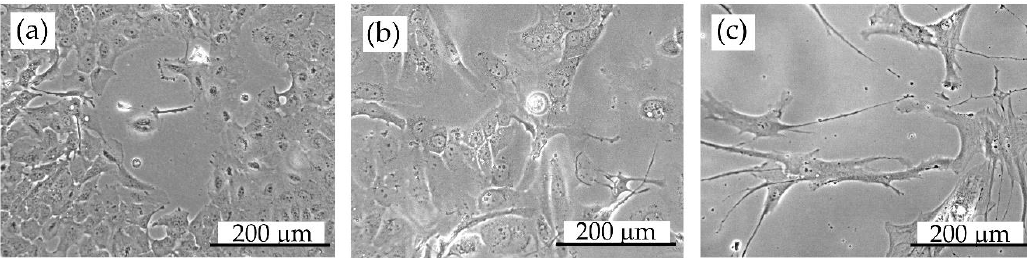
Figure 7. Cell morphology: ( a ) DU145 prostate cancer cells, ( b ) HCC38 breast cancer cells, ( c ) hMSC (human mesenchymal stem cells). Images were taken using an inverse optical microscope (Primo Vert, Zeiss) with a 20× objective. The scale bar is 200 µm.